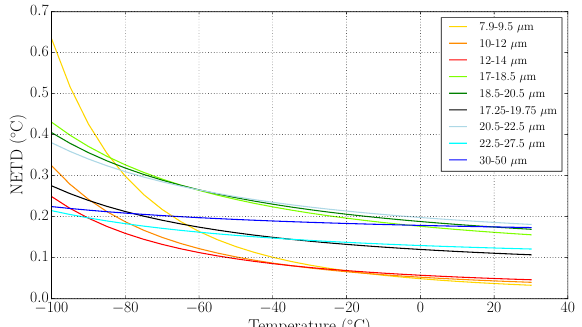
Figure 6. Noise equivalent temperature difference (NETD) corre- sponding to a noise equivalent radiance (NER) of 0.01Wm − 2 sr − 1 , as a function of blackbody temperature for all spectral bands of the FIRR.